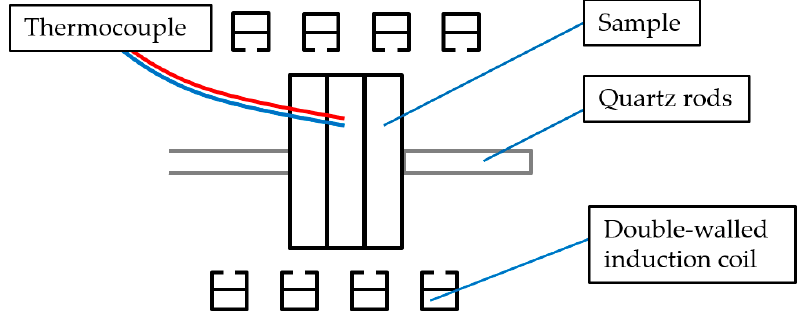
Figure 6. Schematic of the Bähr 805A dilatometer.